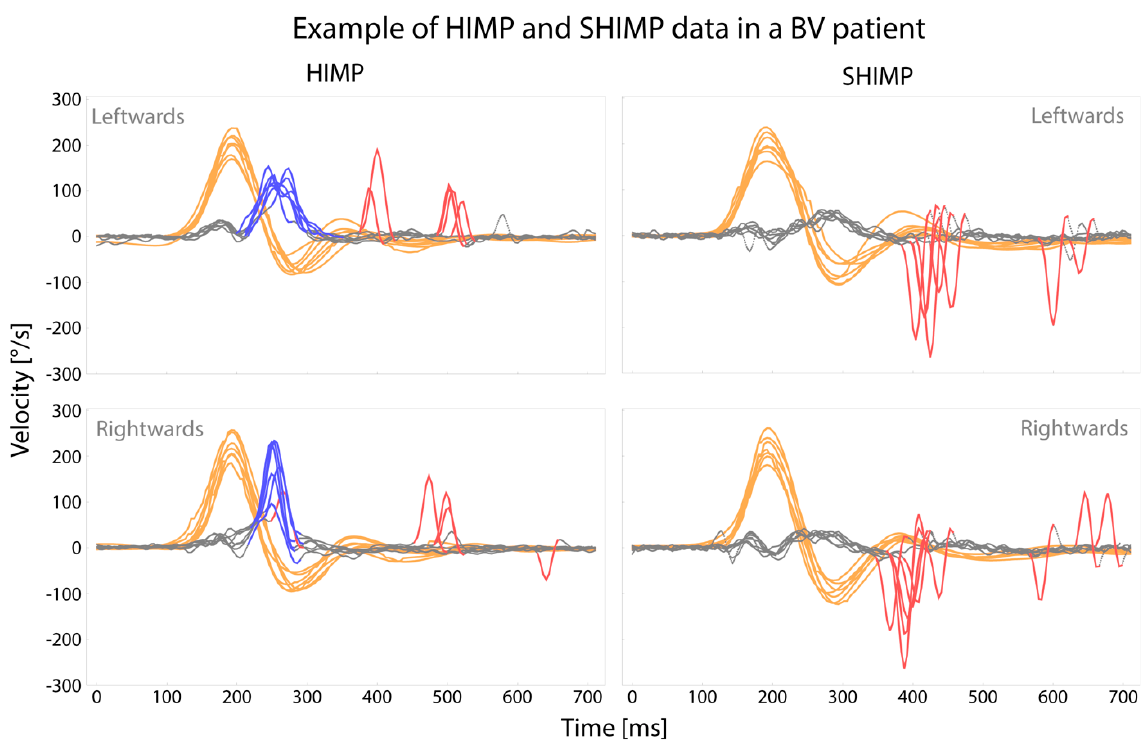
Figure 2. Raw eye and head movement data of one BV patient (patient 18), obtained by HIMP and SHIMP during two consecutive VHIT trials. Grey lines represent eye movements, orange lines represent head movements, blue lines represent covert saccades, and red lines represent overt saccades.